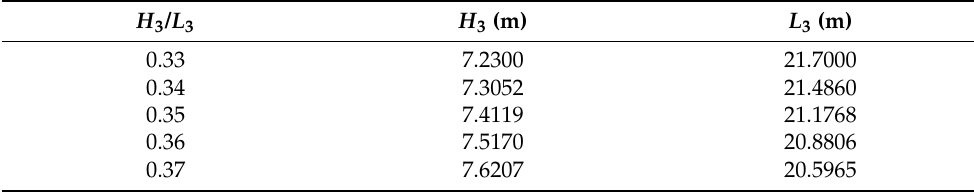
Table 2. Values considered for the ratio H 3 / L 3 .